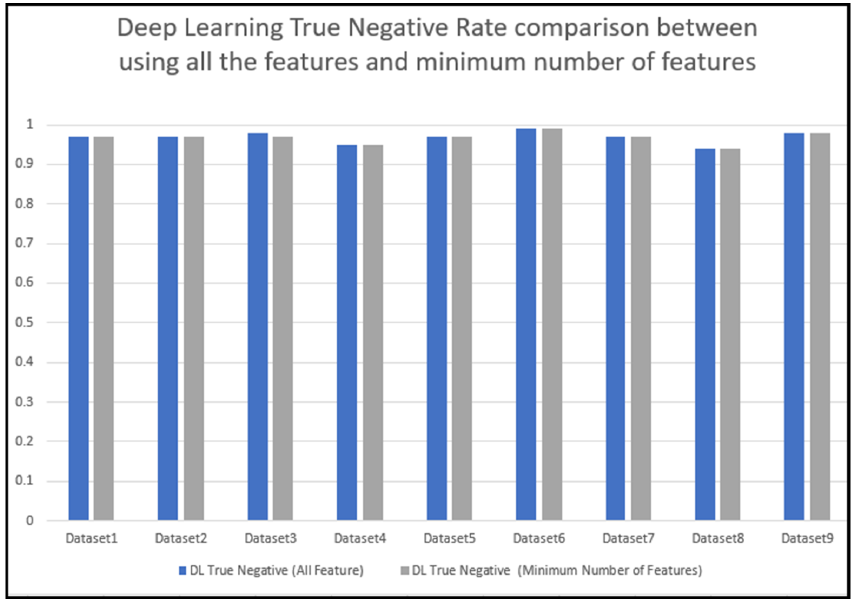
Figure 10. Benign communication prediction results when tested using the minimum number of features.